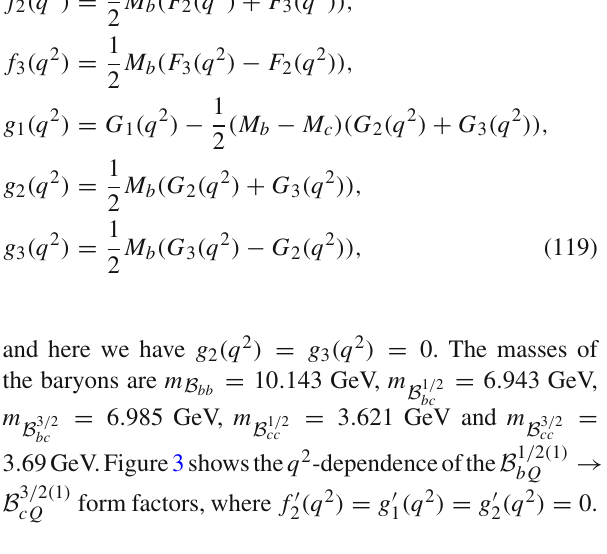
/ 2 ( 1 ) → B 3 / 2 ( 1 ) form factors, where Q = b , bQ cQ